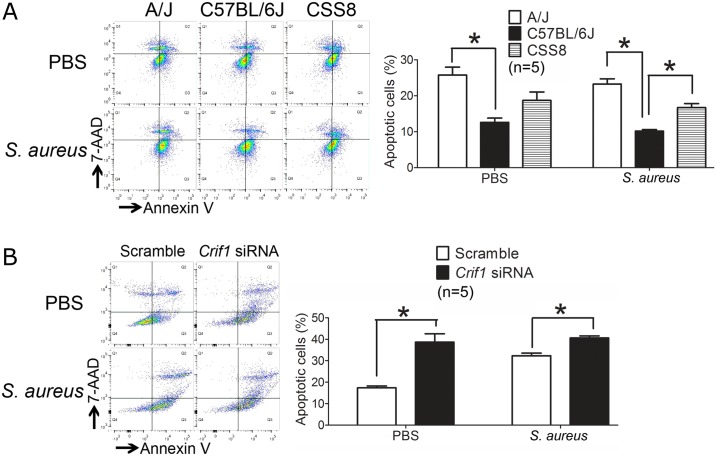
Increased apoptosis is associated with lower Crif1 expression in A/J and CSS8 macrophages.Apoptosis rates in Figs 8A and 8B cannot be compared because transfection experiments, which intrinsically elicit apoptosis, were performed in (B) but not (A). (A) Bone-marrow derived macrophages from A/J and CSS8 demonstrate higher apoptosis level as compared with C57BL/6J in both uninfected (25.8% and 18.7% vs 12.6%; p <0.05) and S. aureus-challenged conditions (23.3% for A/J, 16.7% for CSS8 and 10.2% for C57BL/6J; p<0.05) (n = 5 in each group). (B) Knockdown of Crif1 by siRNA enhances apoptosis in both uninfected and S. aureus-challenged conditions. Knockdown of Crif1 in BMDMs from C57BL/6J mice enhances apoptosis in uninfected status as compared with scramble siRNA (38.7% vs 17.3%; p<0.05). S. aureus stimulation exhibits similar patterns of apoptosis (40.6% vs 32.3%; p<0.05) (n = 5 in each group). Mice were 8-week old males.